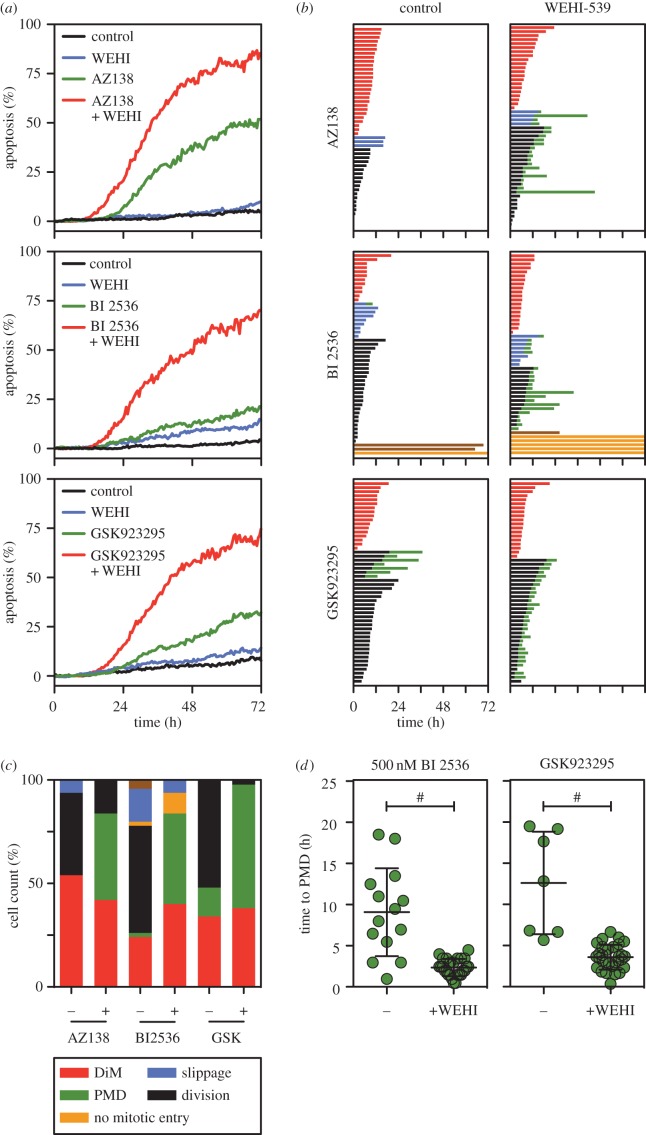
WEHI-539 sensitizes cells to second-generation mitotic blockers. (a) Line graphs showing apoptosis induction over a 72 h time course following exposure of RKO cells to 200 nM of the Eg5 inhibitor AZ138, 50 nM of the Plk1 inhibitor BI 2536, and 100 nM of the Cenp-E inhibitor GSK923295, plus 100 nM WEHI-539. (b) Cell fate profiles of cells treated as in (a). (c) Bar graph quantitation of (b) showing the number of cells undergoing each fate. (d) Scatter plot showing the time from mitotic exit to death for the cells that underwent PMD. Note that in the case of the Plk1 inhibitor, the data in panel (d) are derived from 500 nM BI 2536. #p < 0.0001. Zero hours on the fate profiles represents when cells entered mitosis.